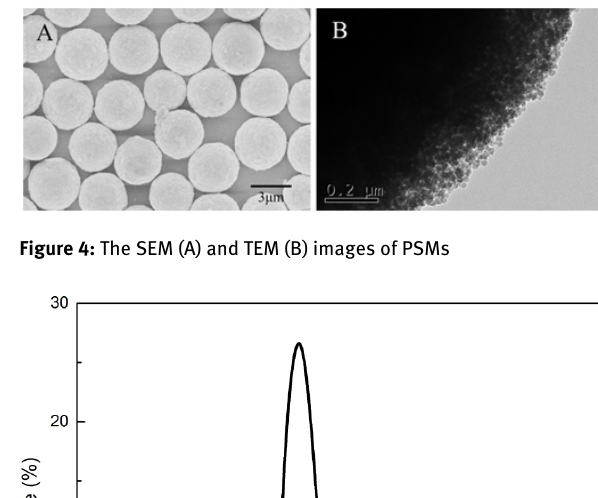
Figure 3: The particle size distributions of PSMs prepared at differ- ent pH